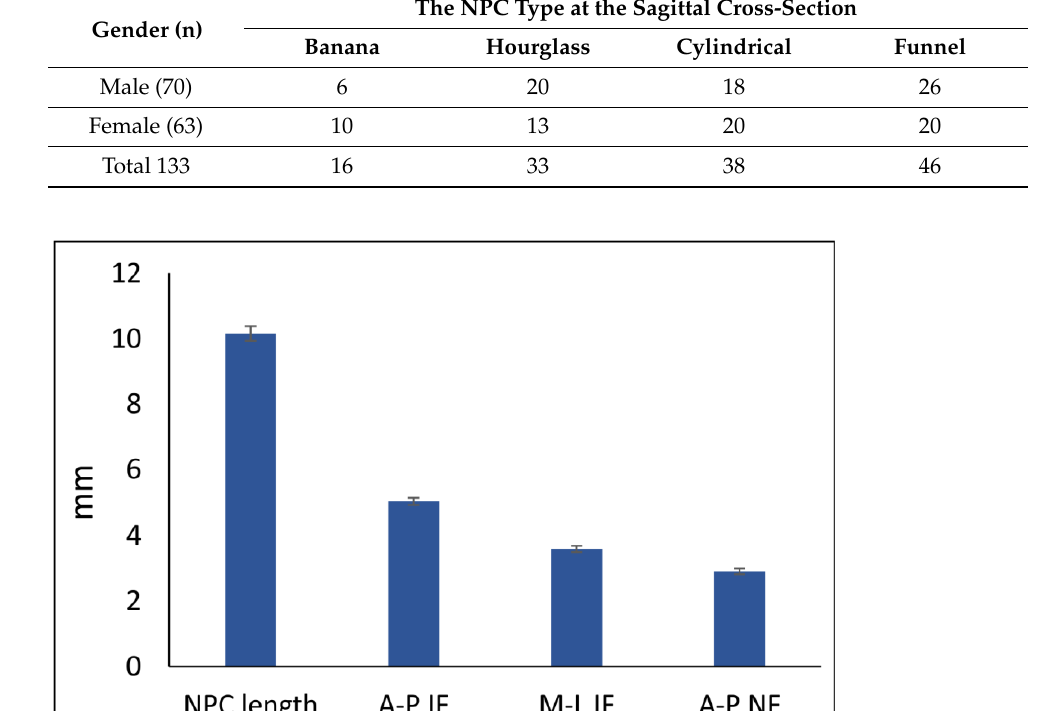
Table 1. NPC type distribution according to gender.